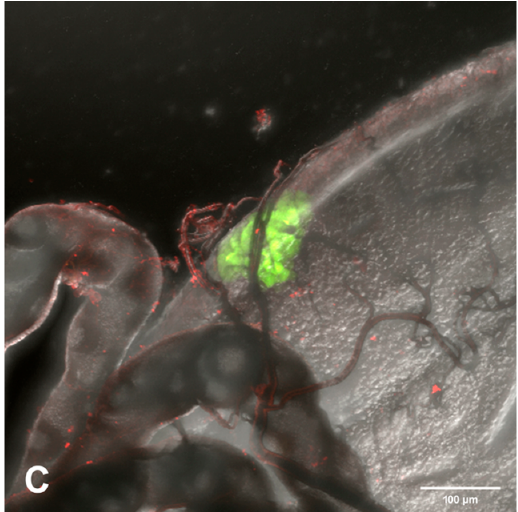
Figure 8. Higher magnification of fluorescent laser confocal analysis of SINV-GFP (green) infection focus and EC specific FMRFamide- TX Red immunoreactivity in the PMG region of mosquito #4 at day 7 p.i. ( A ) Single GFP infection focus. ( B ) FMRFamide positive ECs. ( C ) Merged image of ( A , B ) demonstrating the yellow color observed when SINV and EC colocalize. 400 × .